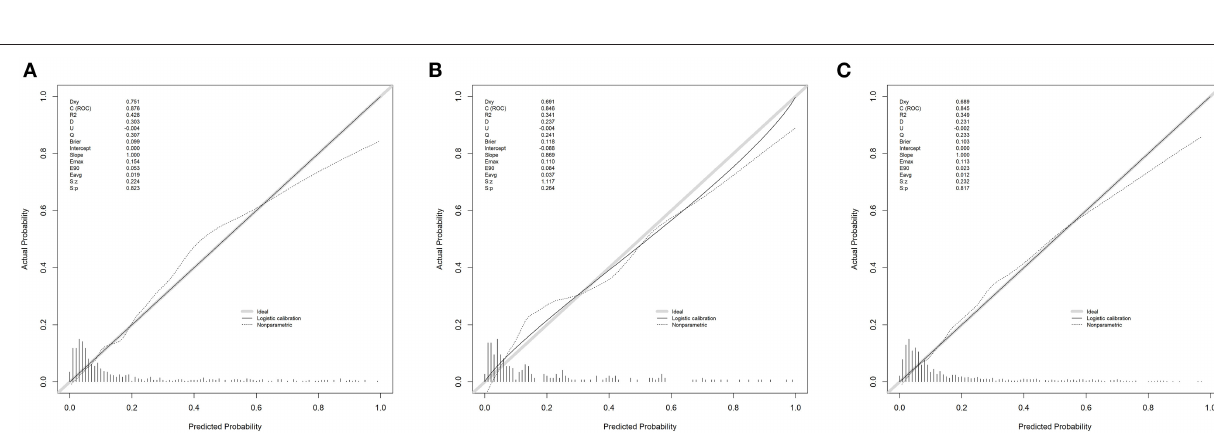
Frontiers in Medicine |